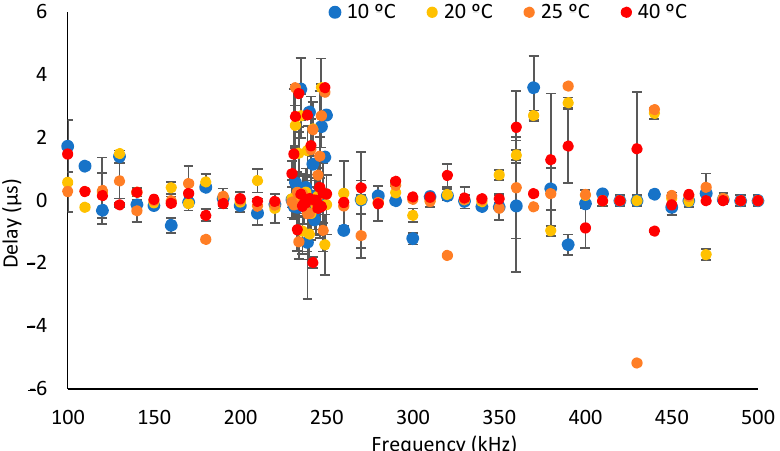
Figure 5. Delay for different frequencies according to the pH value. Data include the repetitions performed for the different temperatures.